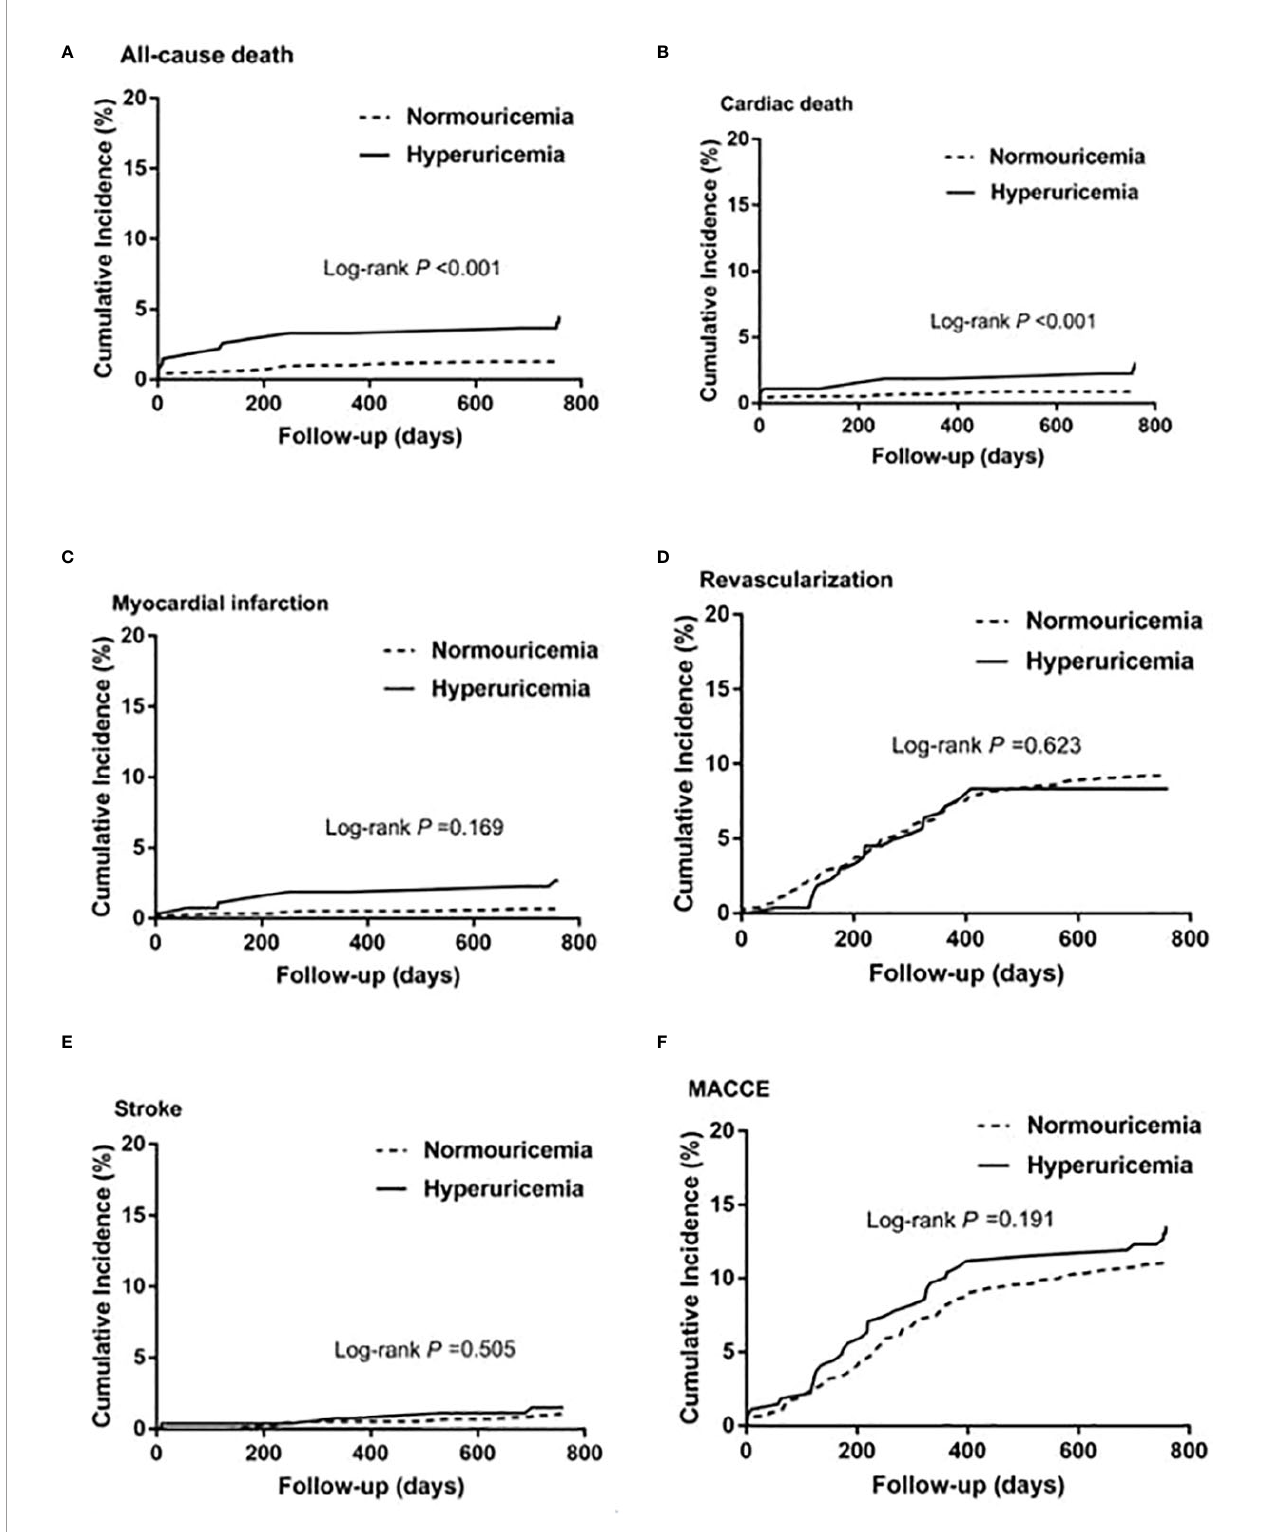
FIGURE 1 | Kaplan – Meier survival curves for 2-year primary and secondary outcomes in STEMI patients with PCI. (A) All-cause death, (B) cardiac death, (C) myocardial infarction, (D) unplanned revascularization, (E) stroke, and (F) MACCE. MACCE, major adverse cardiac and cerebrovascular